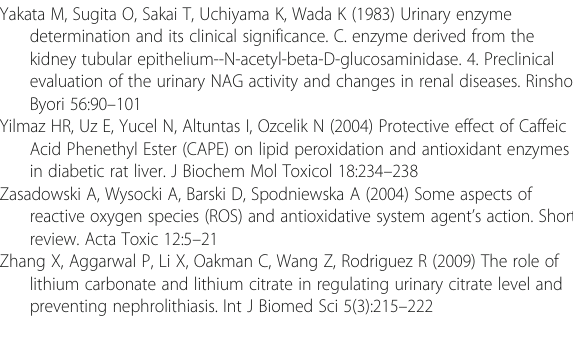
kidney tubular epithelium--N-acetyl-beta-D-glucosaminidase. 4. Preclinical evaluation of the urinary NAG activity and changes in renal diseases. Rinsho Byori 56:90 – 101 Yilmaz HR, Uz E, Yucel N, Altuntas I, Ozcelik N (2004) Protective effect of Caffeic Acid Phenethyl Ester (CAPE) on lipid peroxidation and antioxidant enzymes in diabetic rat liver. J Biochem Mol Toxicol 18:234 – 238 Zasadowski A, Wysocki A, Barski D, Spodniewska A (2004) Some aspects of reactive oxygen species (ROS) and antioxidative system agent ’ s action.